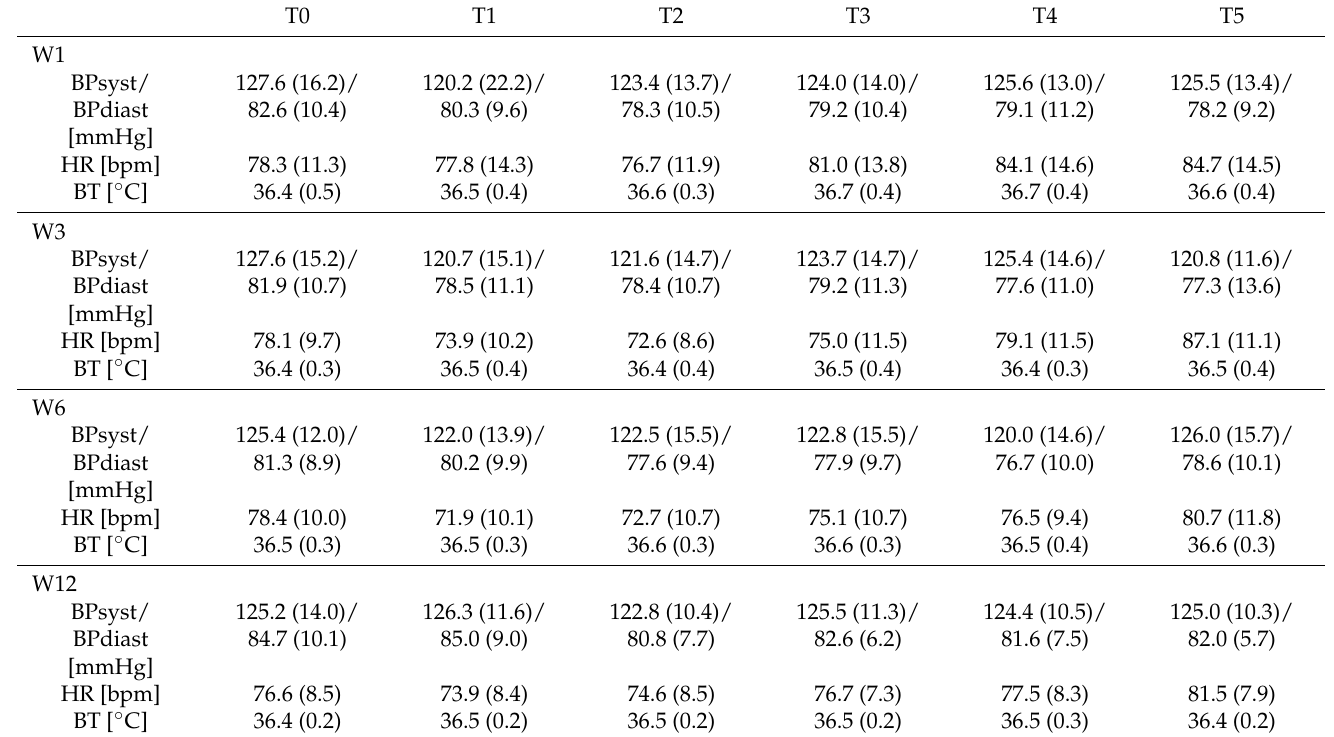
Table 1. Vital signs during OCR